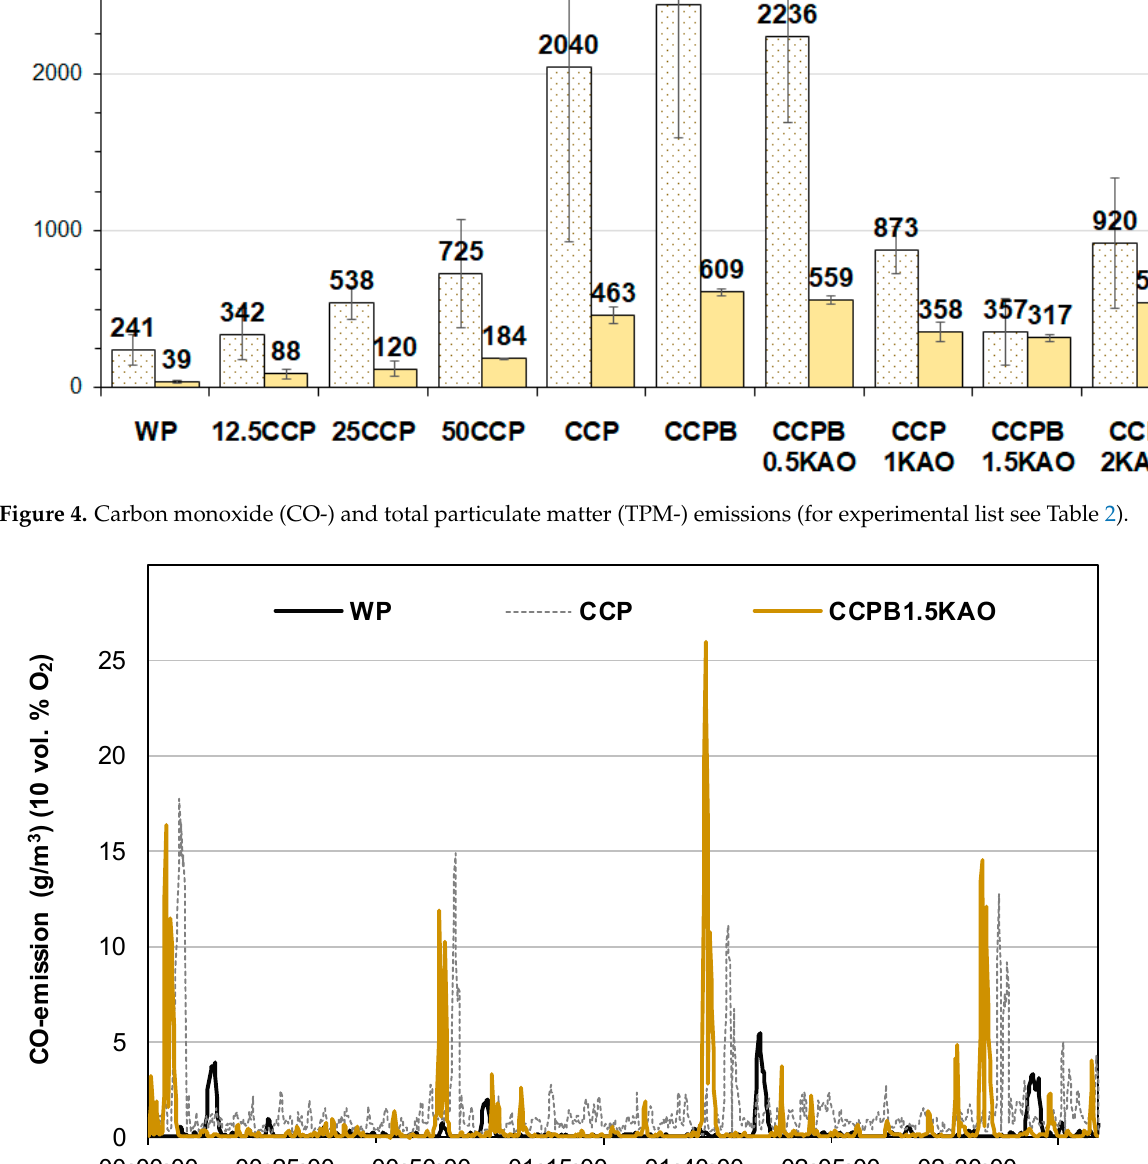
Figure 5. Carbon monoxide (CO-)emission variation during combustion (for experimental list see Table 2).